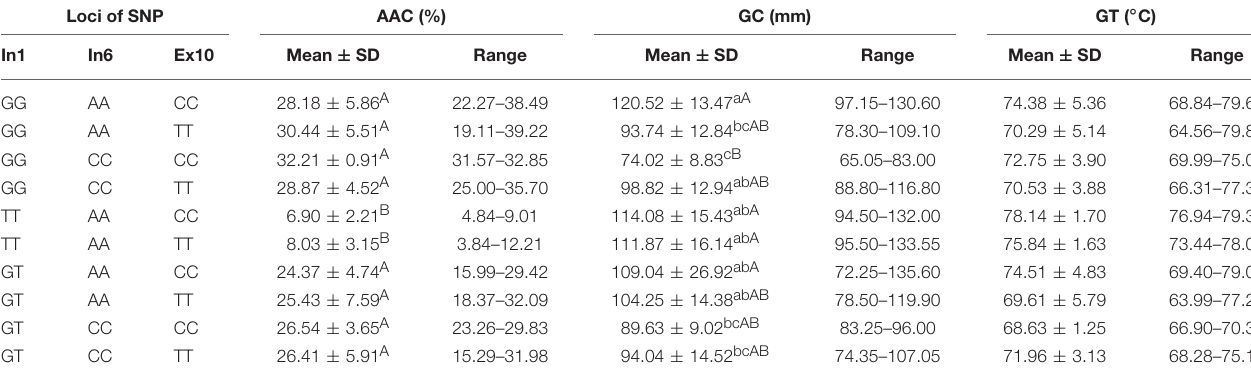
TABLE 7 | ECQs for different haplotypes of In1G/T, Ex6A/C and Ex10C/T polymorphisms of Wx . Loci of SNP